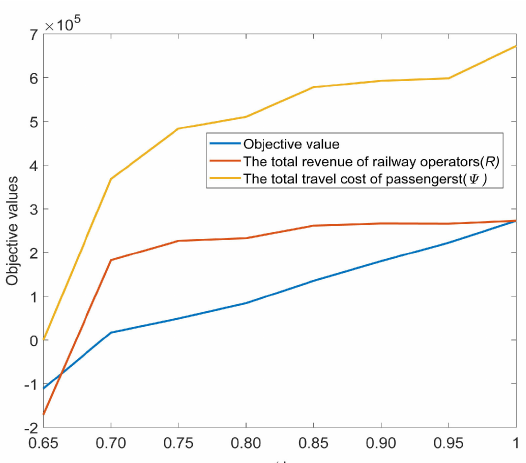
Figure 7. Variation of the value of the objective function with ω ∈ [ 0.65, 1 ]